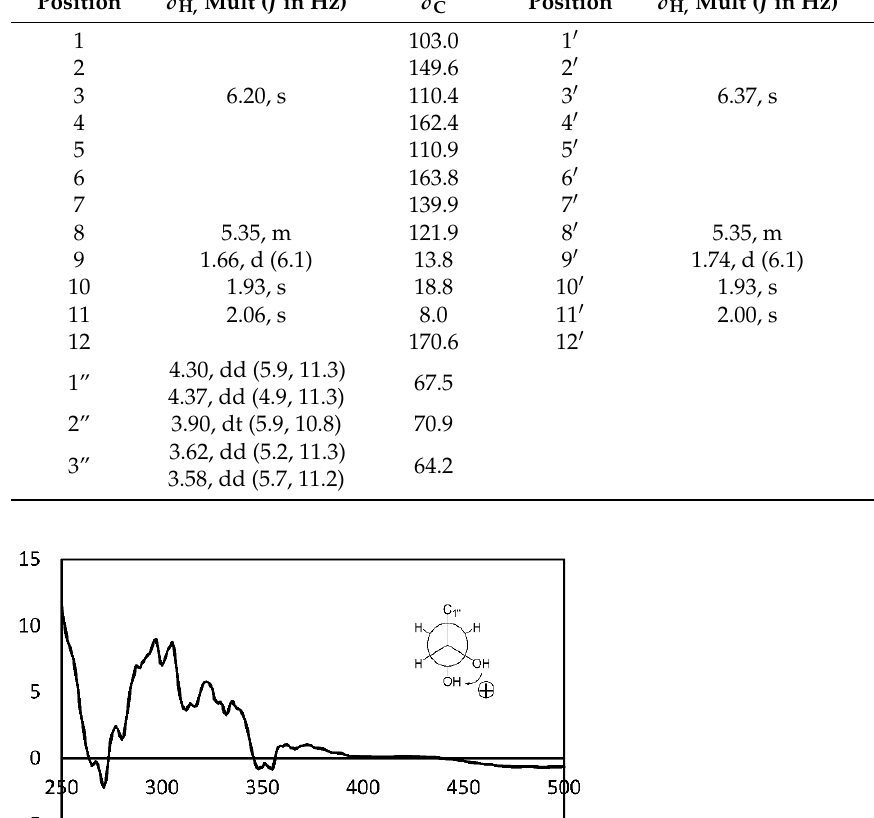
Table 2. 1 H and 13 C NMR data of 12 in CD 3 OD (600 MHz for 1 H and 150 MHz for 13 C).